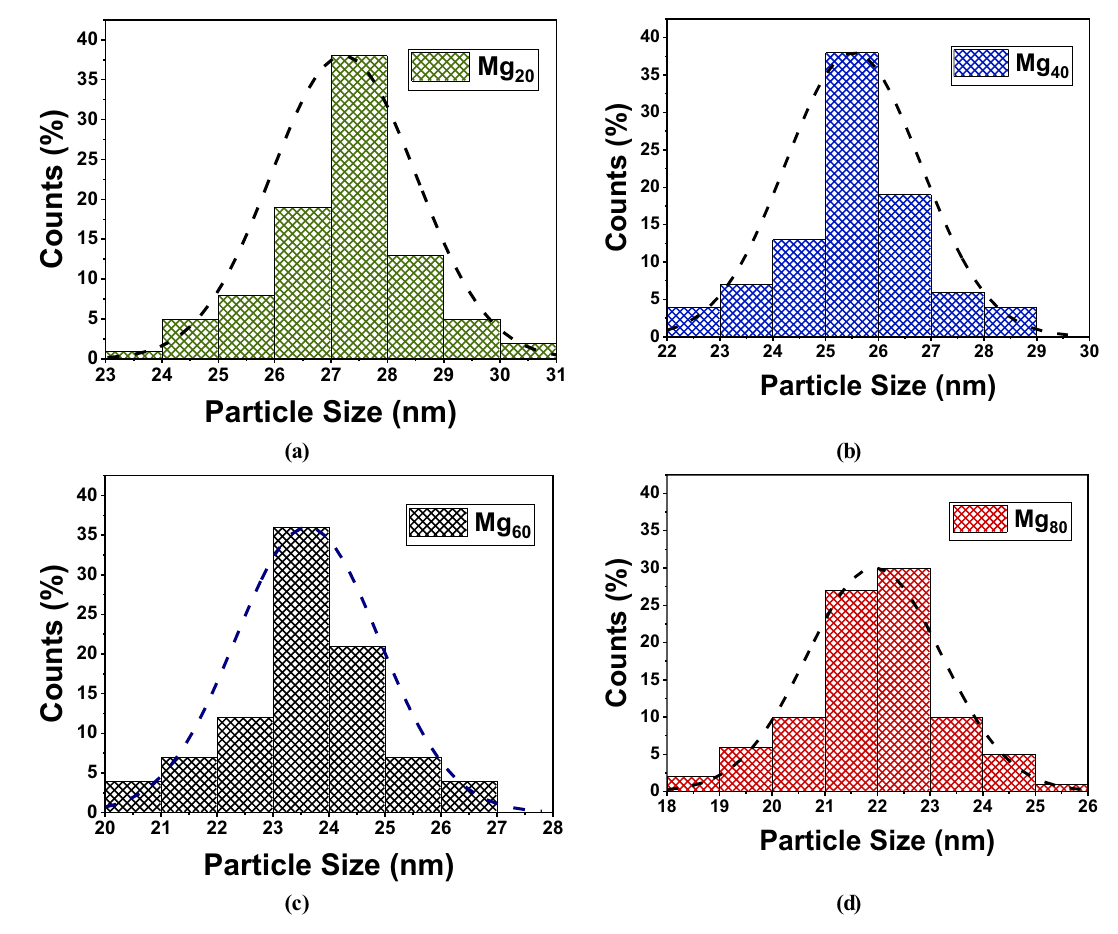
Figure 7. Particle size histogram of Mg–Zn ferrite nanopowder ( a ) Mg 20 , ( b ) Mg 40 , ( c ) Mg 60, and ( d ) Mg 80 respectively.